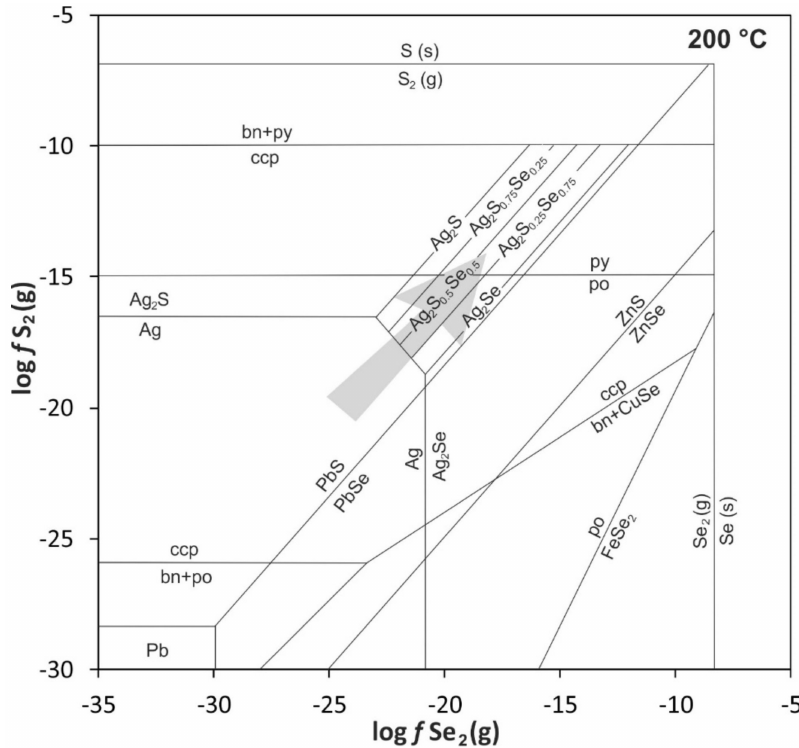
Figure 26. The f S 2 versus fS e 2 diagram showing the relative stability of sulphides and selenides at 200 ◦ C (adopted with permission from Zhuravkova et al. [78]). Arrow indicates probable evolutionary trend during crystallization of the early portion of the studied precious-metal